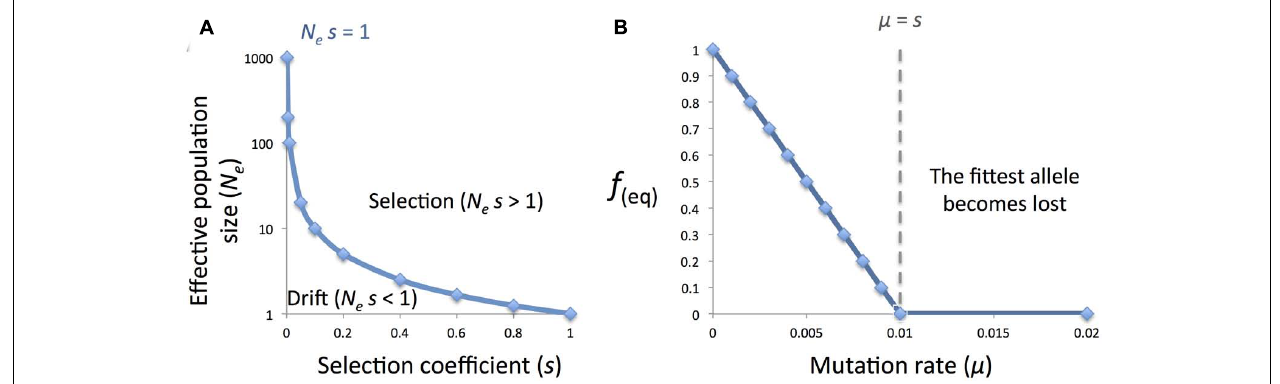
FIGURE 2 | Population genetic models. (A) The fate of an allele is determined by natural selection if the product of the effective population size ( N e ) and the coefficient of selection ( s ) is larger than one, and by genetic drift